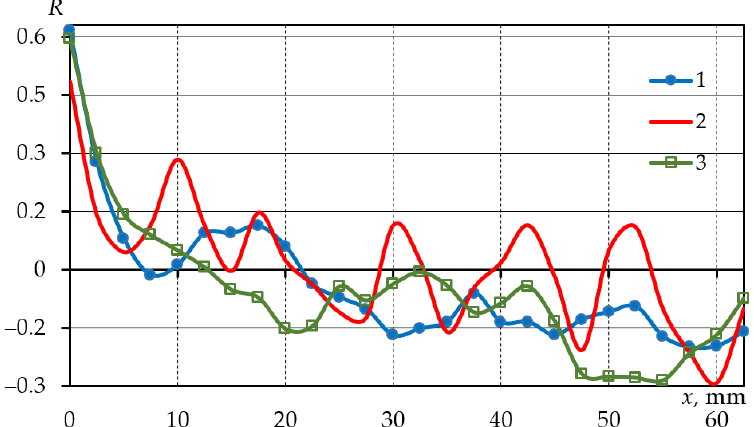
Figure 4. Correlation functions of road surfaces of different roughness: 1 = even, 2 = medium, 3 = very rough. 3 = very